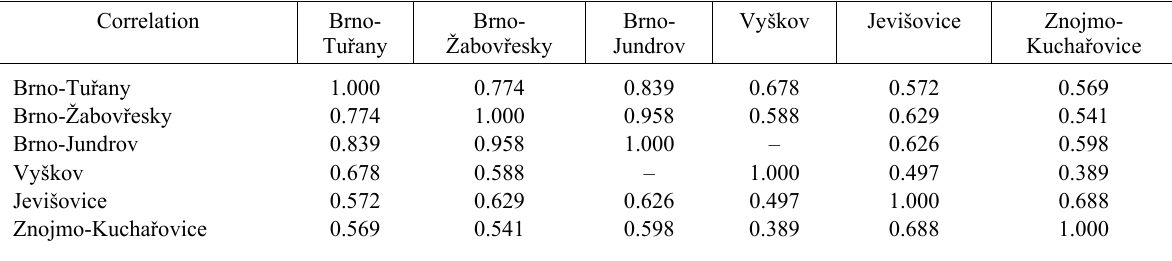
Table 4. Station-to-station correlations (common periods of the series observations) with all the correlations listed being statistically significant at a level of